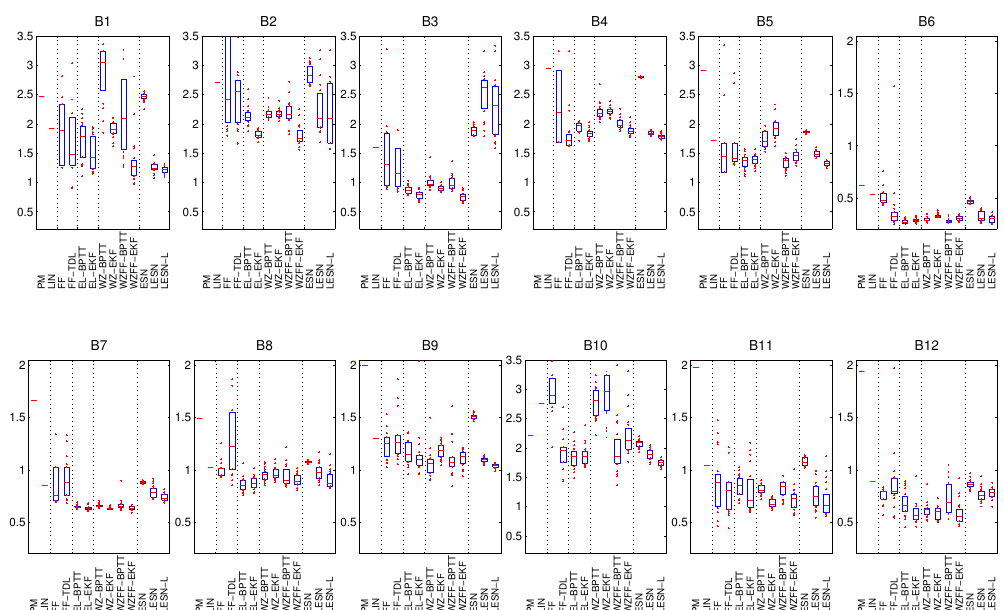
Fig. 7. Test performance in terms of MSDE. The box plot expresses statistics of over 20 models runs. The central mark is the median, the edges of the box are the first and third quartiles, and points outside that range are plotted individually as dots. Note that not all subfigures have the same scale.